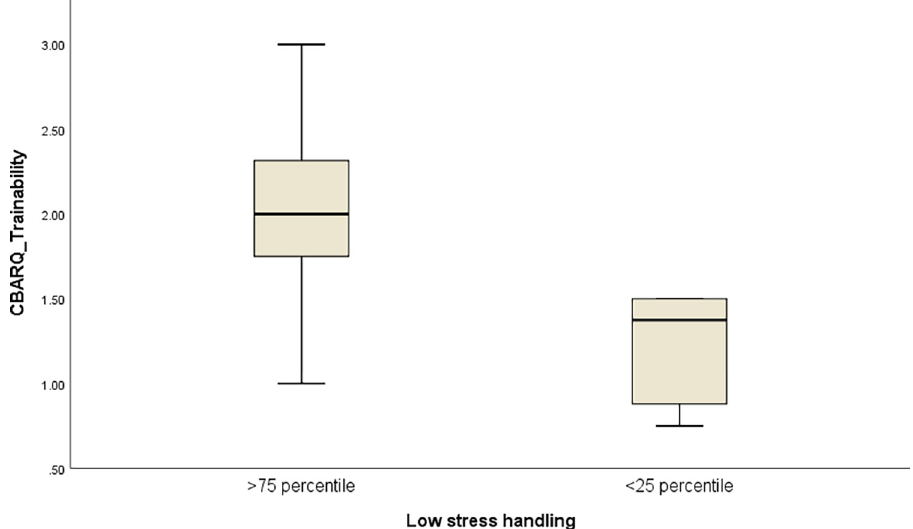
Fig 8. Relationship between management and post-adoption behavior. Boxplot representing the comparison for CBARQ trainability scores between dogs coming from kennels where the breeder was performing regular low-stress handling practices ( > 75th percentile) and dogs coming from kennels where this practice was rarely performed ( < 25th percentile). Values represented are: medians (bar within the box), upper and lower quartiles (borders of box), lowest and highest cases within 1.5 times the IQR (bottom and top